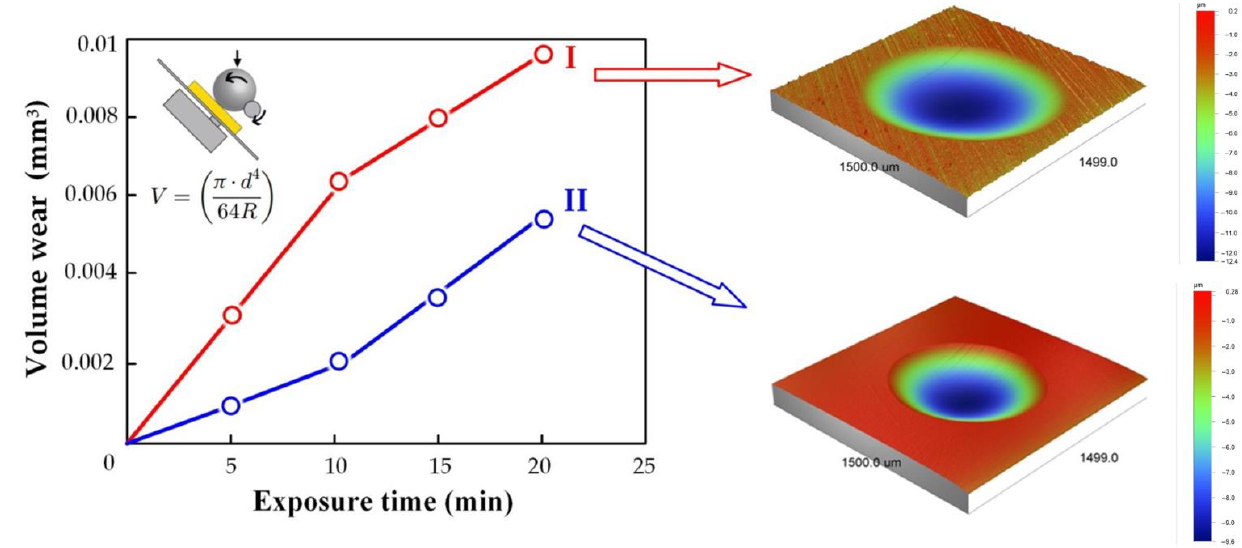
Figure 7. Dependences of the volume wear of SiAlON ceramic inserts with the different conditions of the surface layer after various diamond abrasive machining methods on the time of exposure to a rotating sphere and abrasive particles during testing, where (I) is diamond grinding, (II) is diamond grinding, lapping, and polishing.